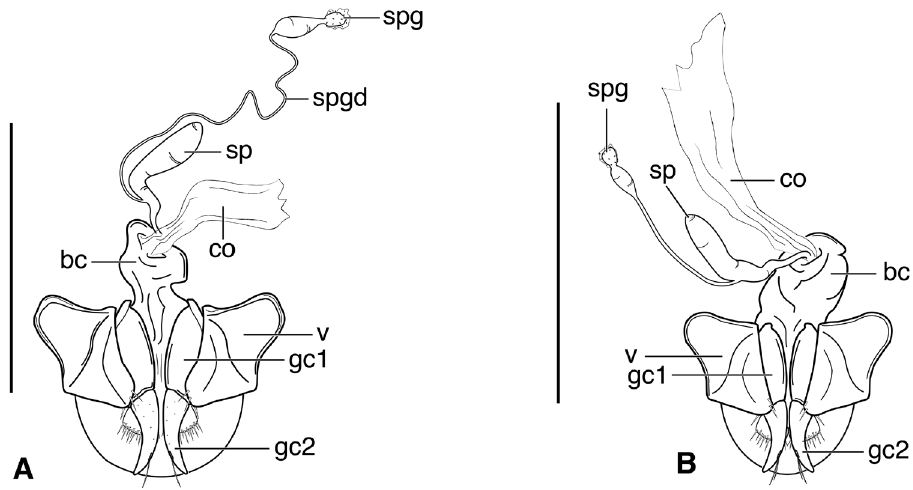
Figure 33. Line drawings of female reproductive tract of Selenophorus mundus species group, in part, ventral aspect. A S. mundus Putzeys B S. pseudomundus Ball & Shpeley. Legend: bc bursa copulatrix co common oviduct gc1 gonocoxite 1 gc2 gonocoxite 2 sp spermatheca spg spermathecal gland spgd spermathecal gland duct; v valvifer. Scale bars 1